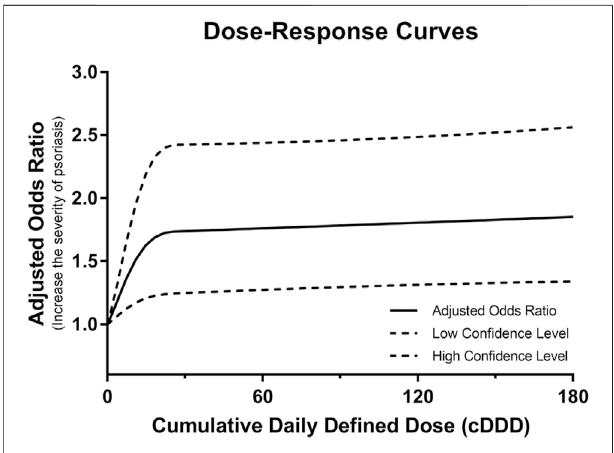
FIGURE 2 | Dose-response curves for the adjusted odd ratios and 95% con fi dence intervals of the psoriasis exacerbation risk as a function of the benzodiazepine receptor agonist dose among patients with mild